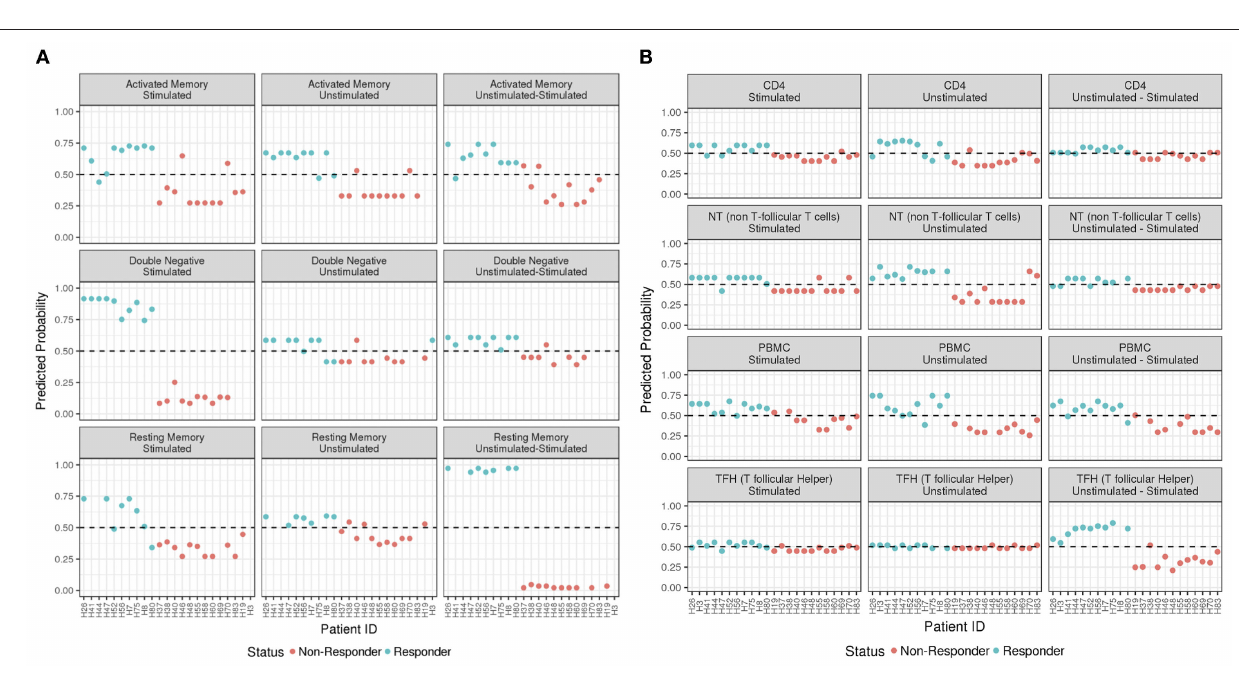
feature selection significant genes, the final model uses the intersection (B cells) or union (T cells) of the genes across subsets. The R statistical software version 3.0.3 was used for all analyses